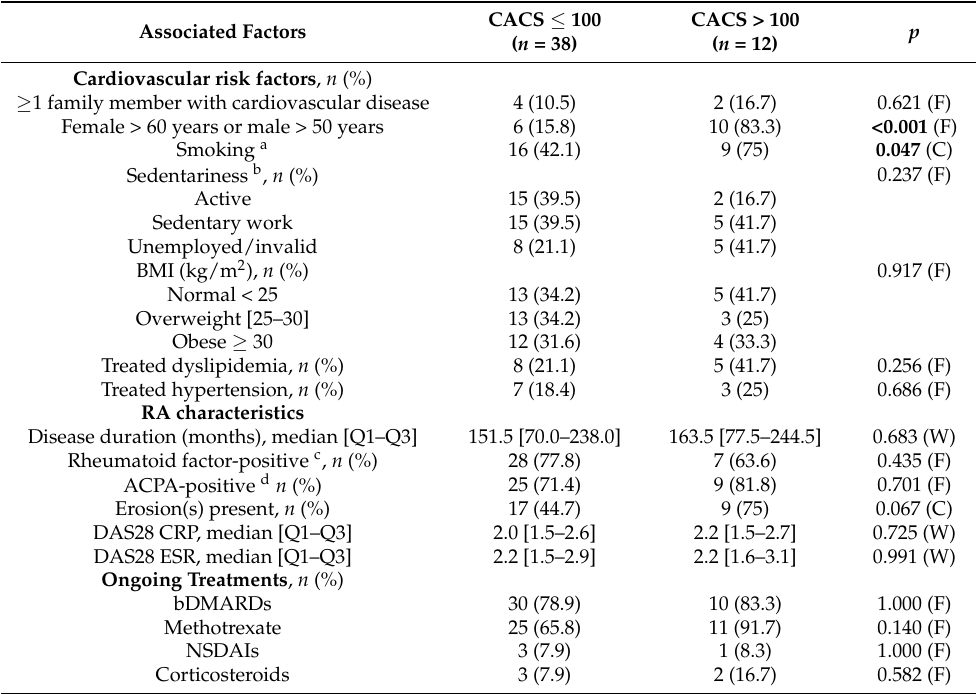
Figure 2. Lipid profile and SATs echo-Doppler abnormalities according to CACS. Table 4. Factors associated with a CACS >